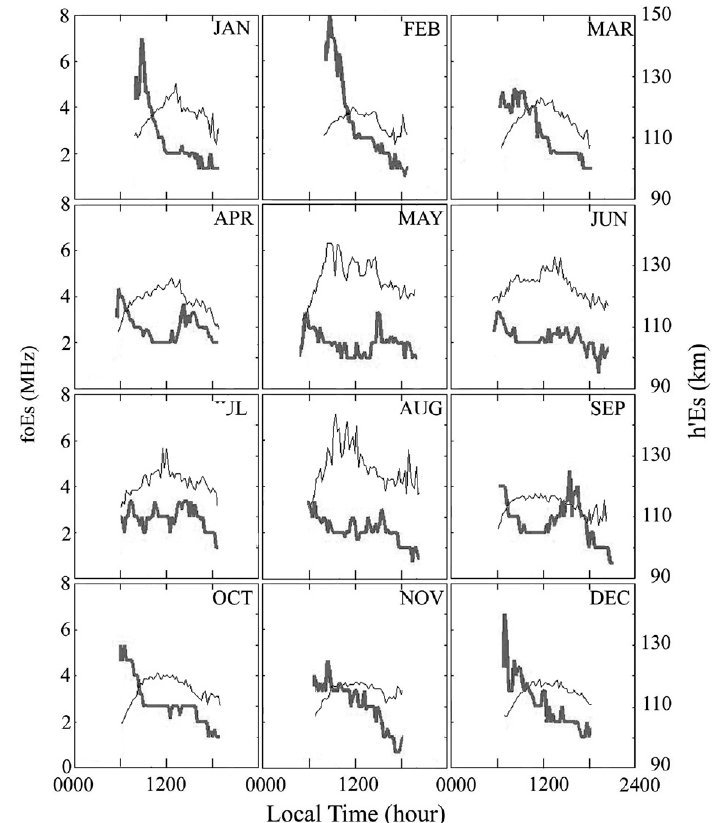
Fig. 4. Median values of the fo Es (thin line) of the intermediate layer in January–December, respectively. The bold line represents the h 0 Es associated with the intermediate layers. The de- scents of the layer in the single-peak months and of the morning layer in the double-peak months are related to the increase of layer frequency